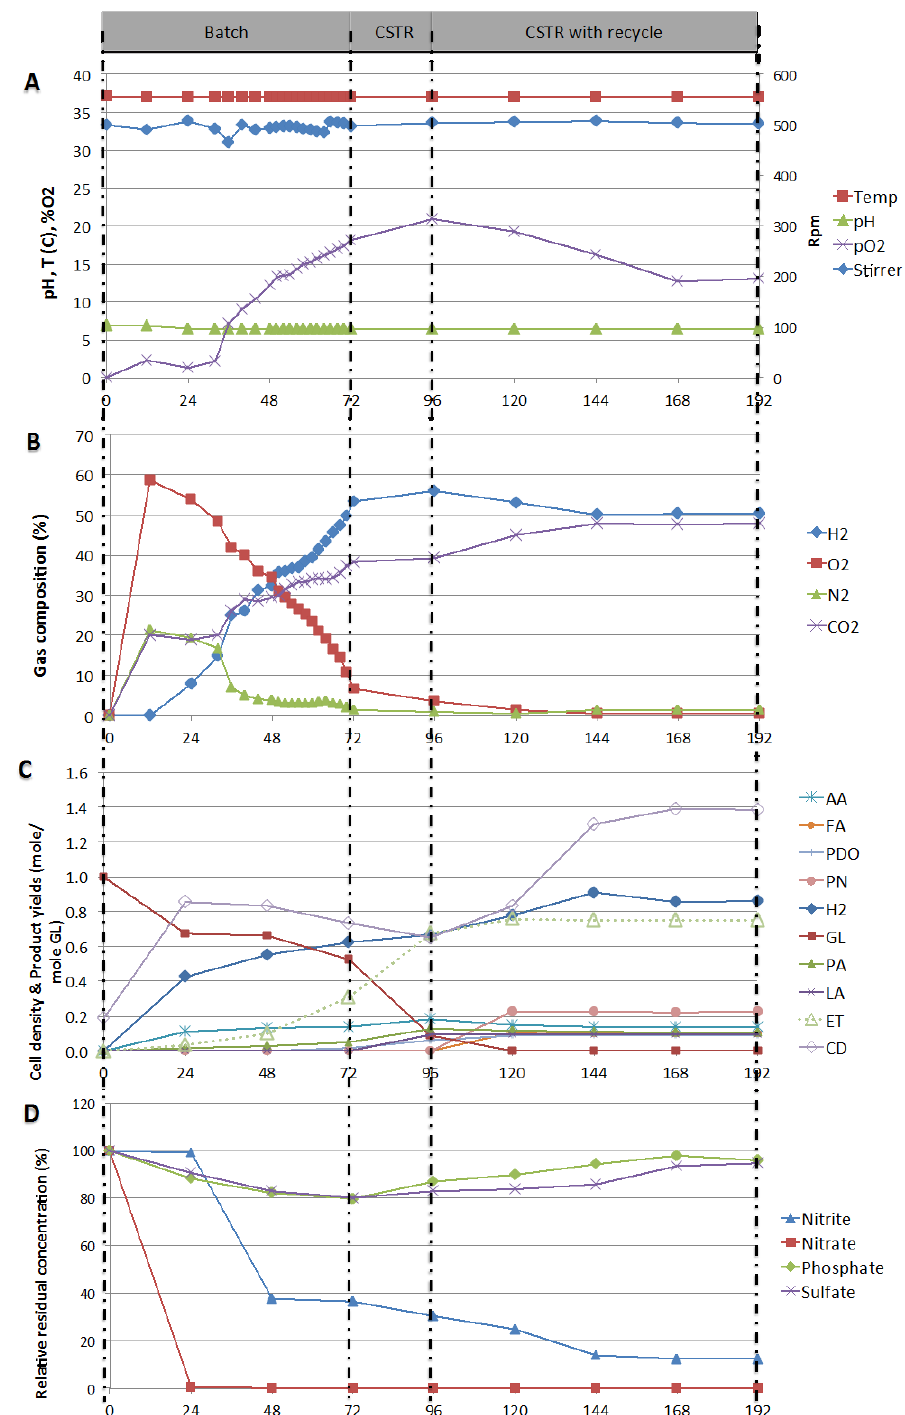
Figure 5. ( A ) Process parameters: pO 2 , Mixing speed (rpm), Temperature (°C), and pH; ( B ) Gas compositions: H 2 , O 2 , N 2 , and CO 2 ; ( C ) Cell density (CD), residual glycerol and products yields; ( D ) Percent relative residual concentration of anions, with respect to time over the three mode of operation batch (I), continuous (II) and continuous with recycling